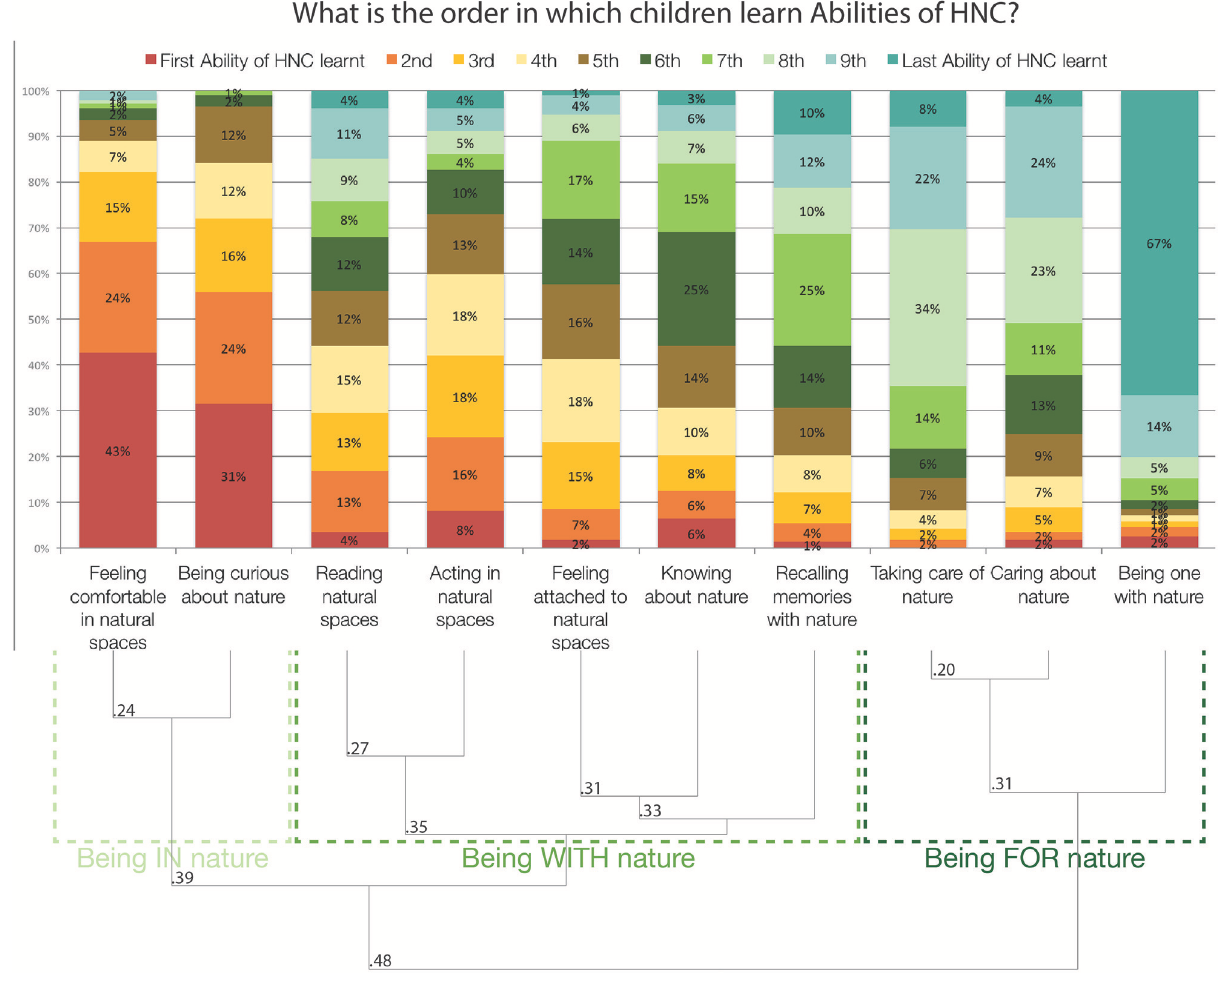
FIGURE 4 | Results from the ordering exercise in the survey showing the progression of abilities of HNC in time. Top: each stacked column shows the percentages of professionals that placed as first, second, third, etc., or last each learnt ability of HNC. Bottom: the upside-down dendogram obtained from the hierarchical analysis of dissimilarity with height coefficients. The three obtained phases of HNC progression are also shown: being IN Nature, being WITH nature, and being FOR